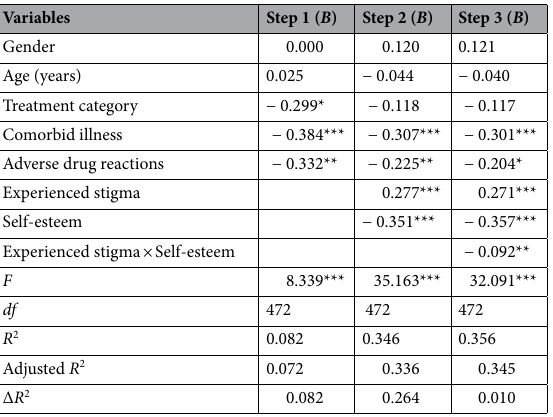
Table 4. Results of hierarchical multiple regression analysis on depression. df degrees of freedom. * P < 0.05. ** P < 0.01. *** P < 0.001 (two-tailed).